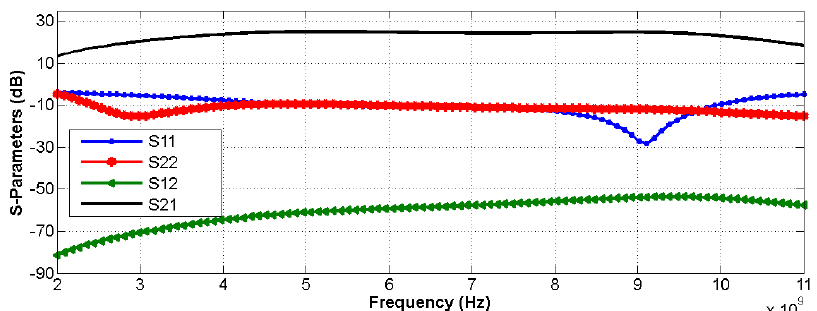
Figure 8. Postlayout simulation of s-parameters ( S 11 ), ( S 22 ) ,( S 12 ), and ( S 21 ).